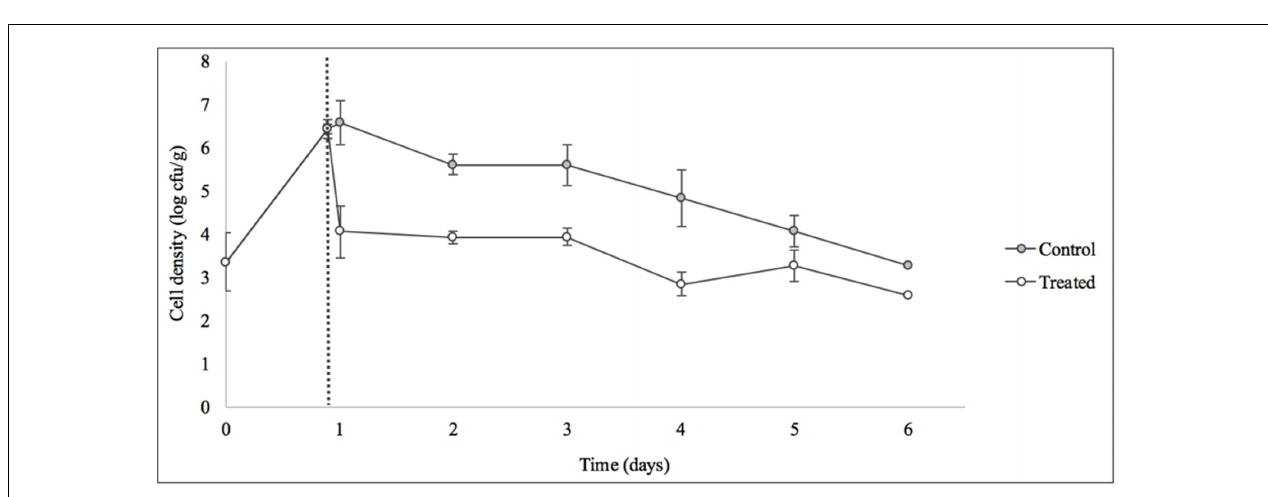
FIGURE 9 | Control of S. Enteritidis on sprouting alfalfa seeds with phage SI1. Dotted line indicates the phage treatment at 22 h after artificial contamination of the seeds. Data shown are the mean of three replicates ±